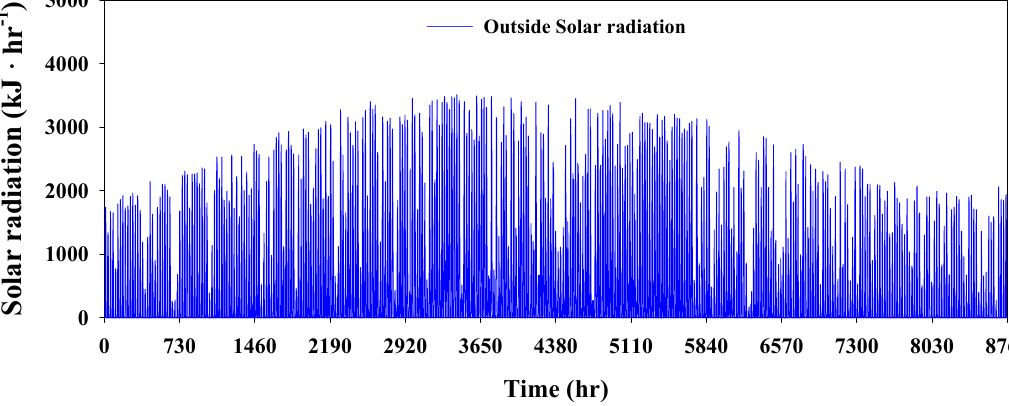
Figure 4. Hourly solar radiation outside the greenhouse.